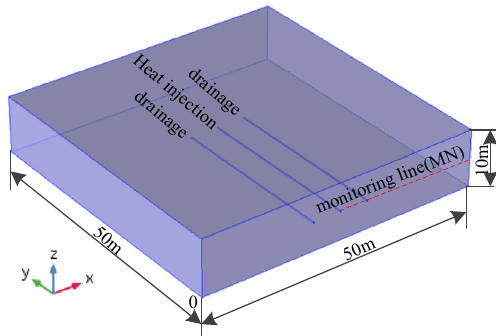
Fig. 1 Numerical model for a typical case of gas drainage in a coal